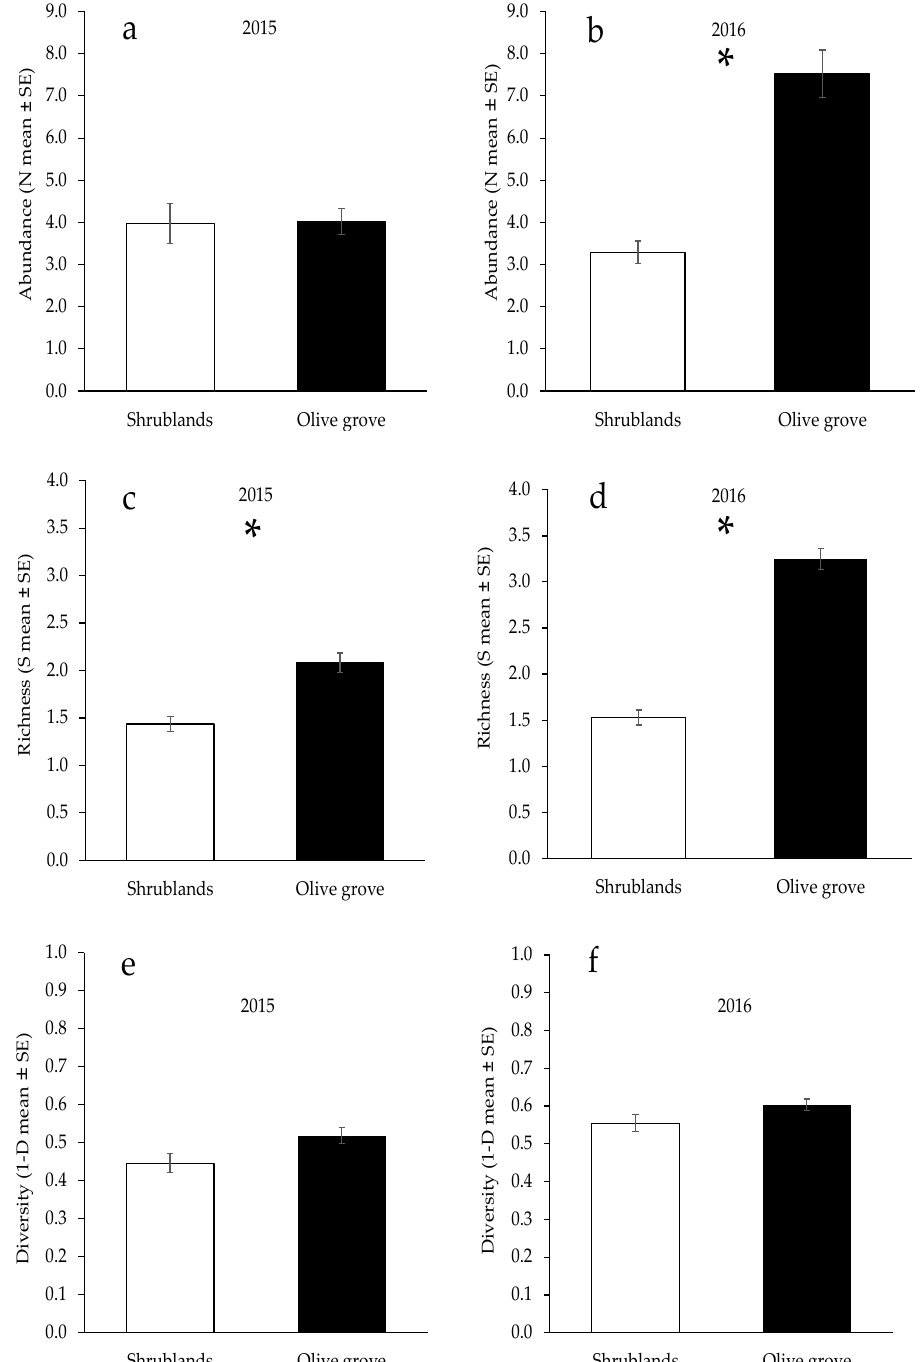
Figure 3. Comparison of the samples of Coleoptera (GEEs) between the two studied habitats (olive grove and adjacent shrublands) in the Mirandela region (Northeast Portugal) in 2015 and 2016. ( a , b ): Total abundance; ( c , d ): Richness of families; ( e , f ): Simpson index for families. Asterisk (*) indicates significant differences between habitats (α < 0.01).